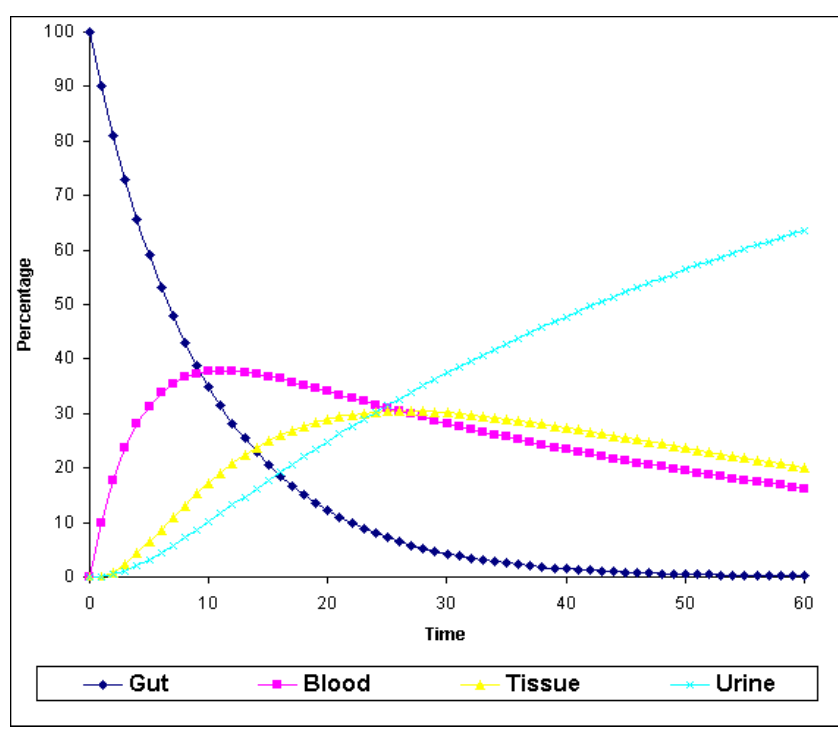
FIGURE 3 . Typical simulation of absorption of drug from the gut, distribution into tissues, and elimination into